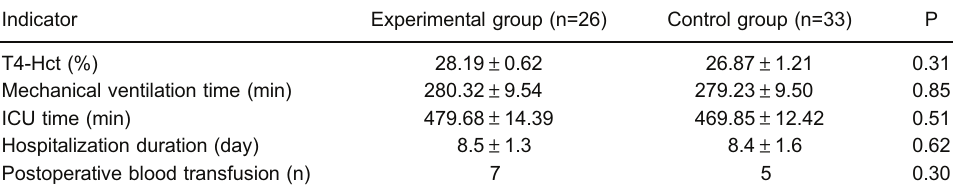
Table 3. Postoperative indicators between two